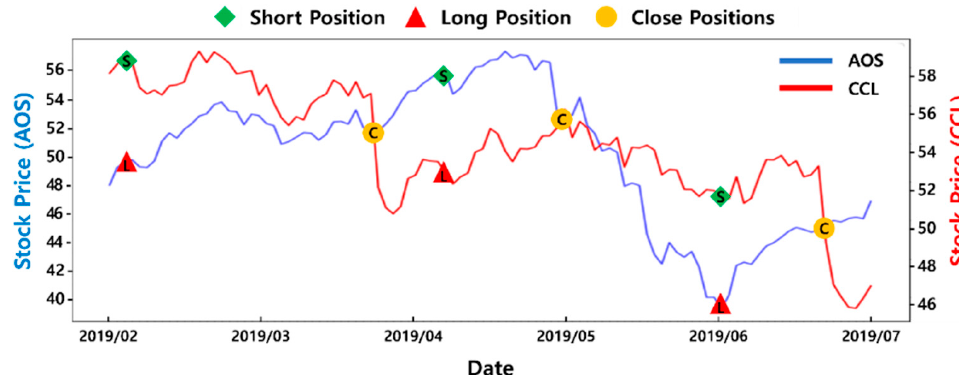
Figure 1. Similar price movements of a stock pair (AOS and CCL).